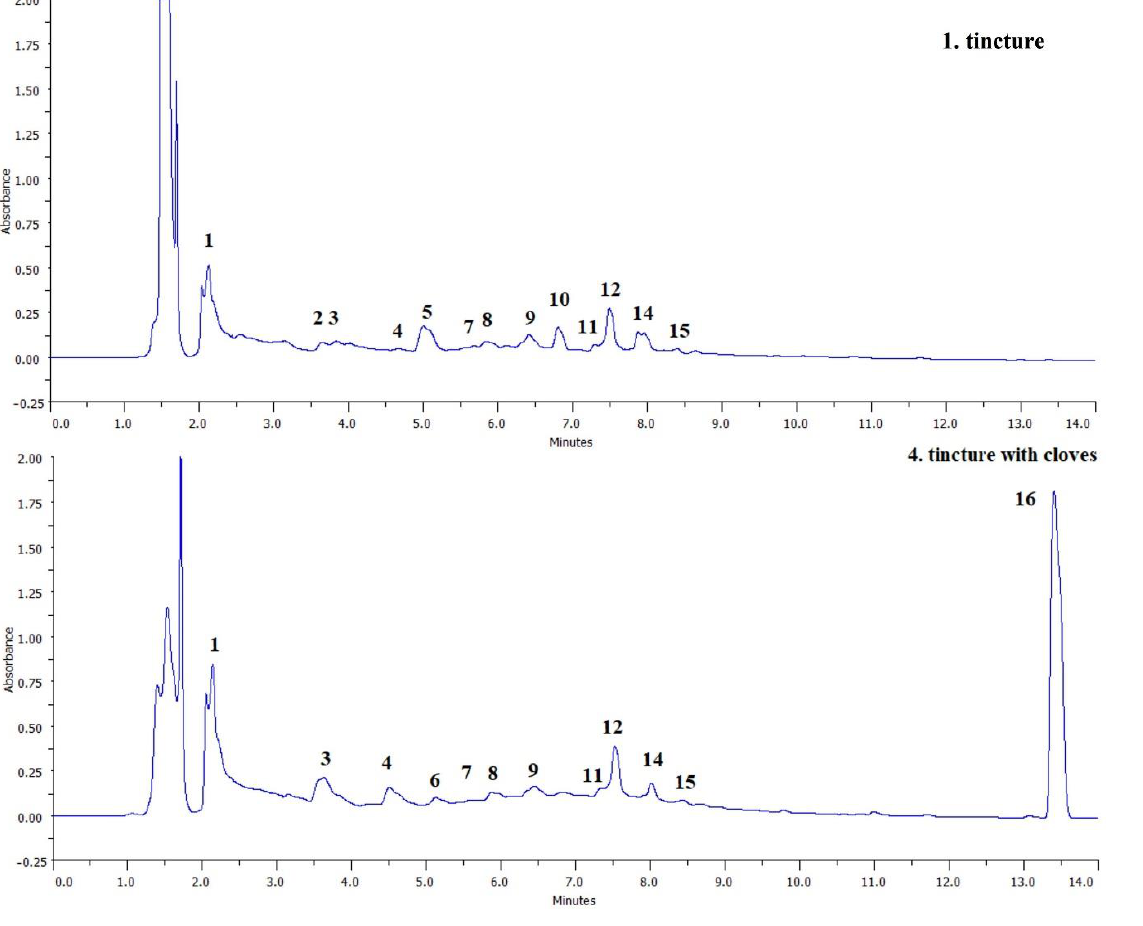
Figure 2. Example chromatograms of tinctures 1 and 4. Peak numbers correspond to the numbering in Table 4.